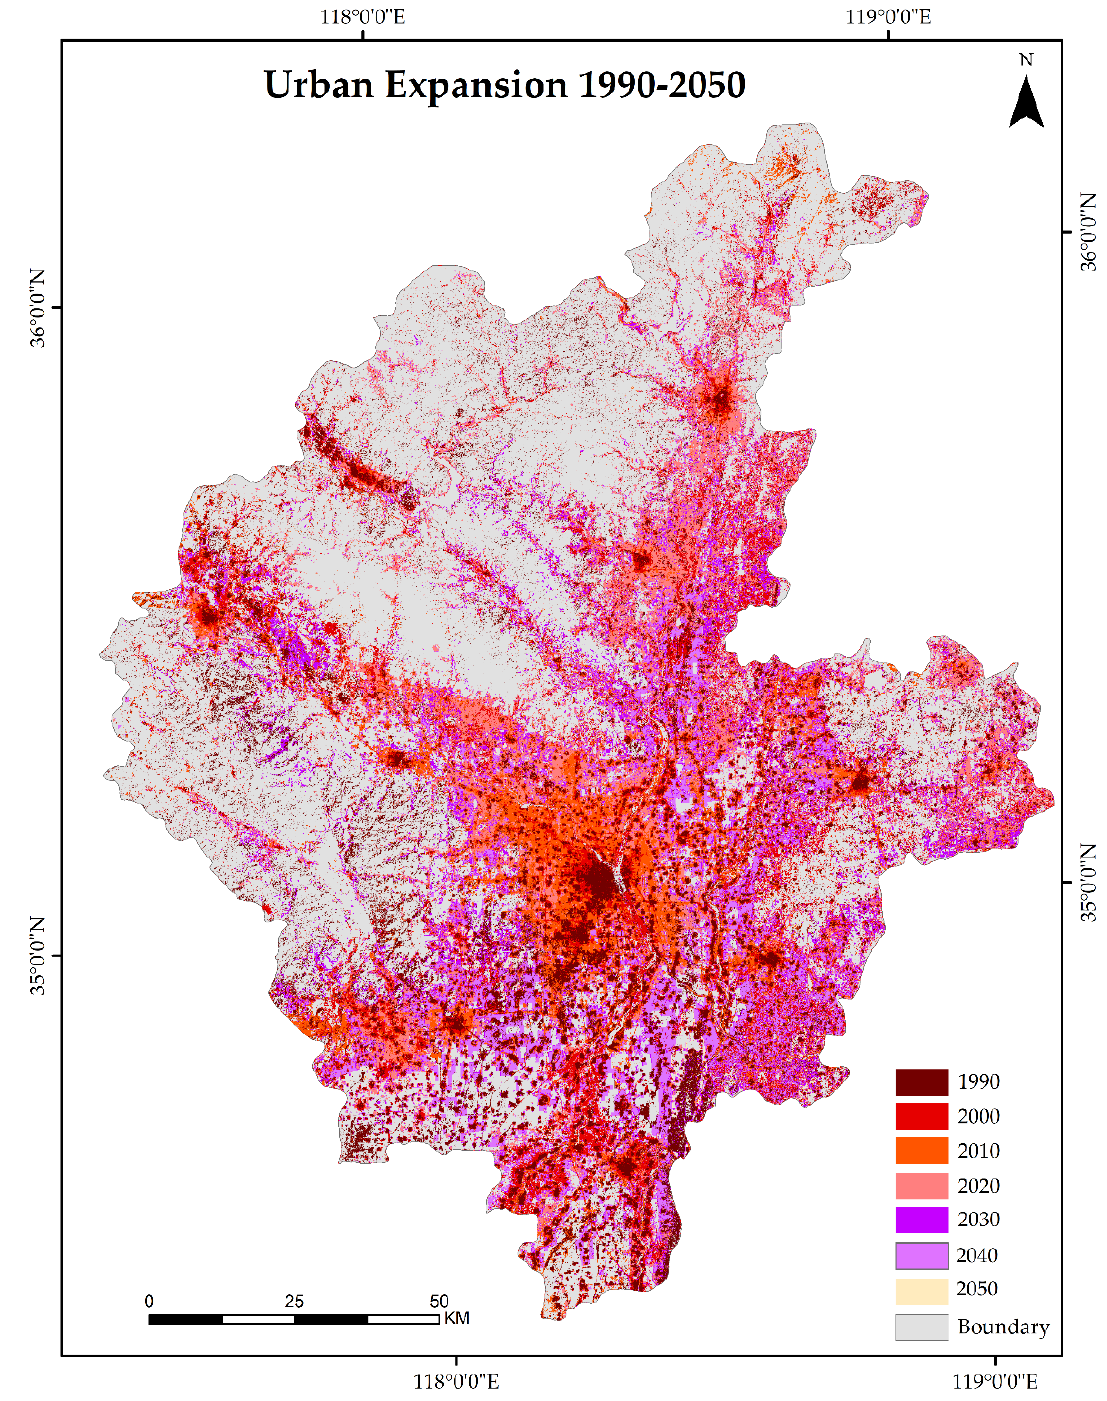
Figure 4. Linyi urban expansion (1990–2050). The LULC change analysis explores the spatial dynamic variations in the LULC pattern during the study period. The results from 1990 to 2020 show a notable expansion in impervious surface and a shrinking phenomenon in the forest, green area, and barren land. Figure 5 and Table 4 show the spatiotemporal area and percentage change in all LULC categories. Forest, green area, water, and barren land contributed 5.72%, 21.24%, 0.44%, and 19.45% to the impervious surface, respectively. Figure 6 and Table 5 represent the inter-transition and contribution of LULC categories to changing phenomena from 1990 to 2020. Green area was the largest contributor to the change from 1990–2020, with